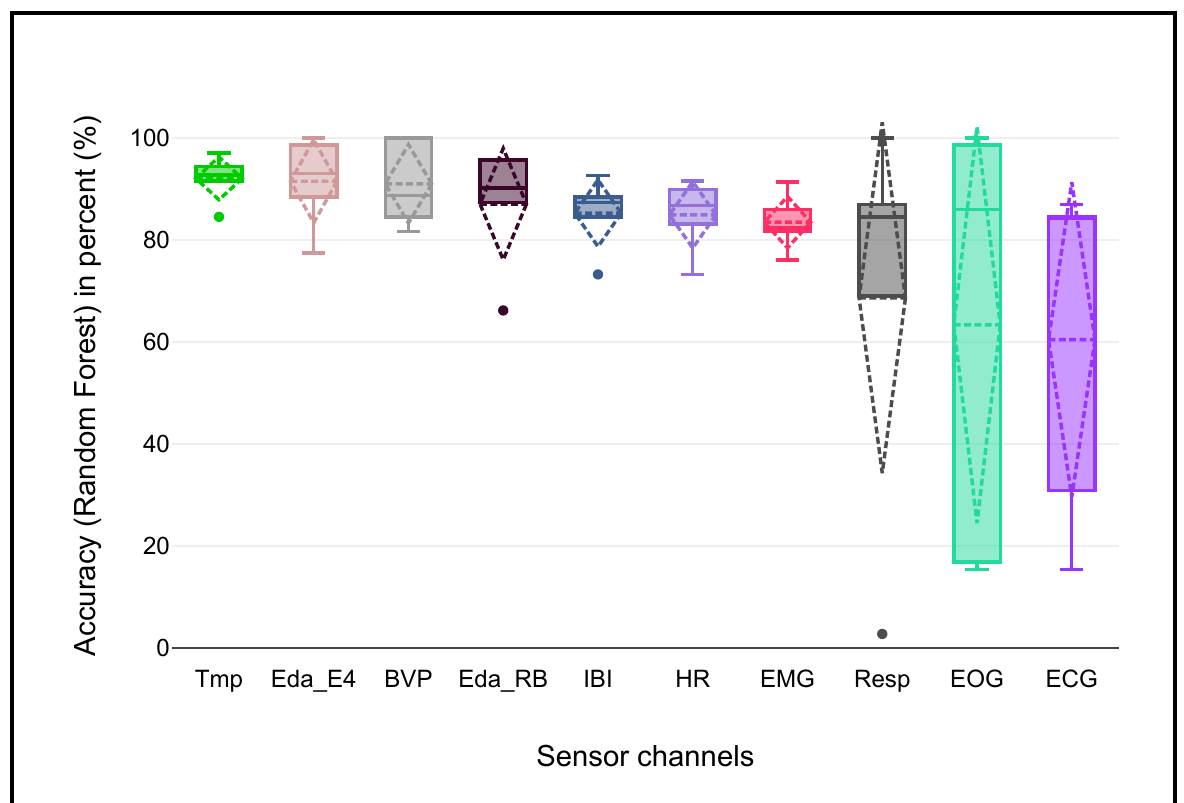
Figure 5. Importance of each sensor channel in recognizing hunger and